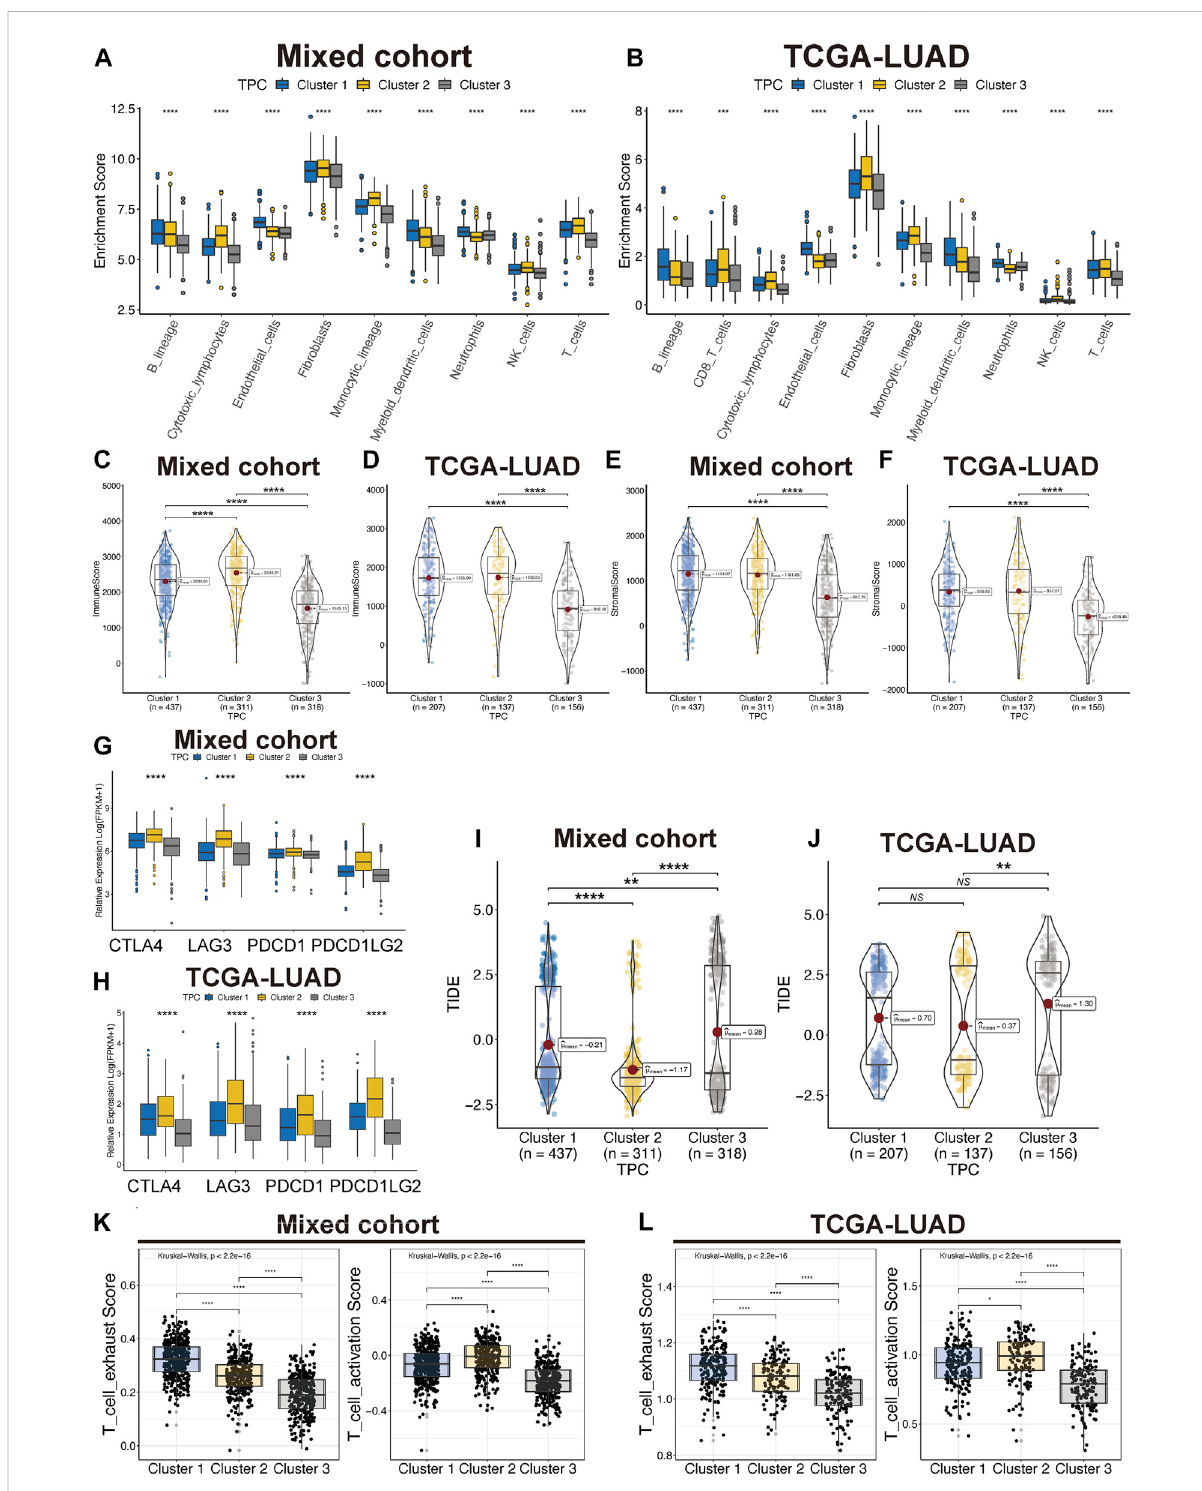
FIGURE 4 Tumor immune microenvironment of TPC. (A,B) Distribution of T cell in lung cancer and TME in mix-cohort (A) and TCGA-LUAD (B) . (C – F) ESTIMATE tumor purity algorithm was used to calculate the immune score and the stromal score of three TPC patients in the mix-cohort (C,E) and TCGA-LUAD (D,F) cohort. (G,H) Abnormal expression of immune checkpoint markers between TPC in mix-cohort (G) and TCGA-LUAD cohort (H) . (I,J) TIDE score of mix-cohort (I) and TCGA-LUAD (J) between TPC group. (K,L) T cell activation/exhaust score of mix-cohort (K) and TCGA- LUAD (L) between TPC